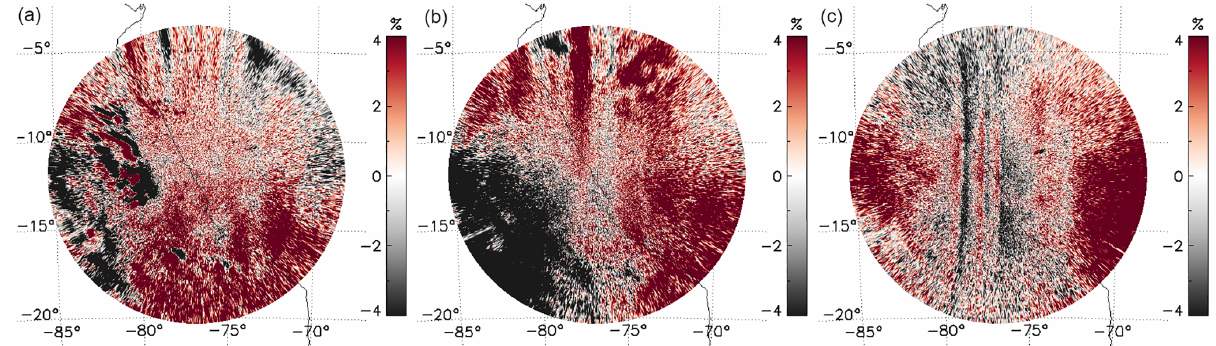
Figure 7. Three unwarped difference images from 29 October 2014. These images show the difference between two consecutive images by subtracting the earlier image from the later image. These images are then scaled to their average value in order to show increase and decrease as a percent. Red is positive, black is negative, white shows no difference, and the color scale shows the difference values in percent. This technique brings out details that may not be as clear in images like Fig. 2. Airglow depletions in these images are visible as alternating red and black regions. The depletions move between images so subtracting the earlier image from the later image means that both positive and negative values can indicate depletions. Positive values indicate the western edge of depletions in the earlier image and negative values indicate the eastern edge of depletions in the later image. Values close to zero between red and black regions are where the depletions overlap. Coordinates show geographic latitude and longitude. The plus sign in (b) is the location of the ASI. The black line shows the western coast of Peru. (a) Unwarped image 03:36UT (LT = UT − 5). Clouds are responsible for the black patches to the west of − 80 ◦ . Depletions are visible at the northern edge of the image. (b) Unwarped image at 04:31UT. The red band around − 77 ◦ and adjacent darker regions show the presence of a depletion extending from the north down past zenith. (c) Unwarped image at 09:08UT. Three depletions are visible between − 80 and − 75 ◦